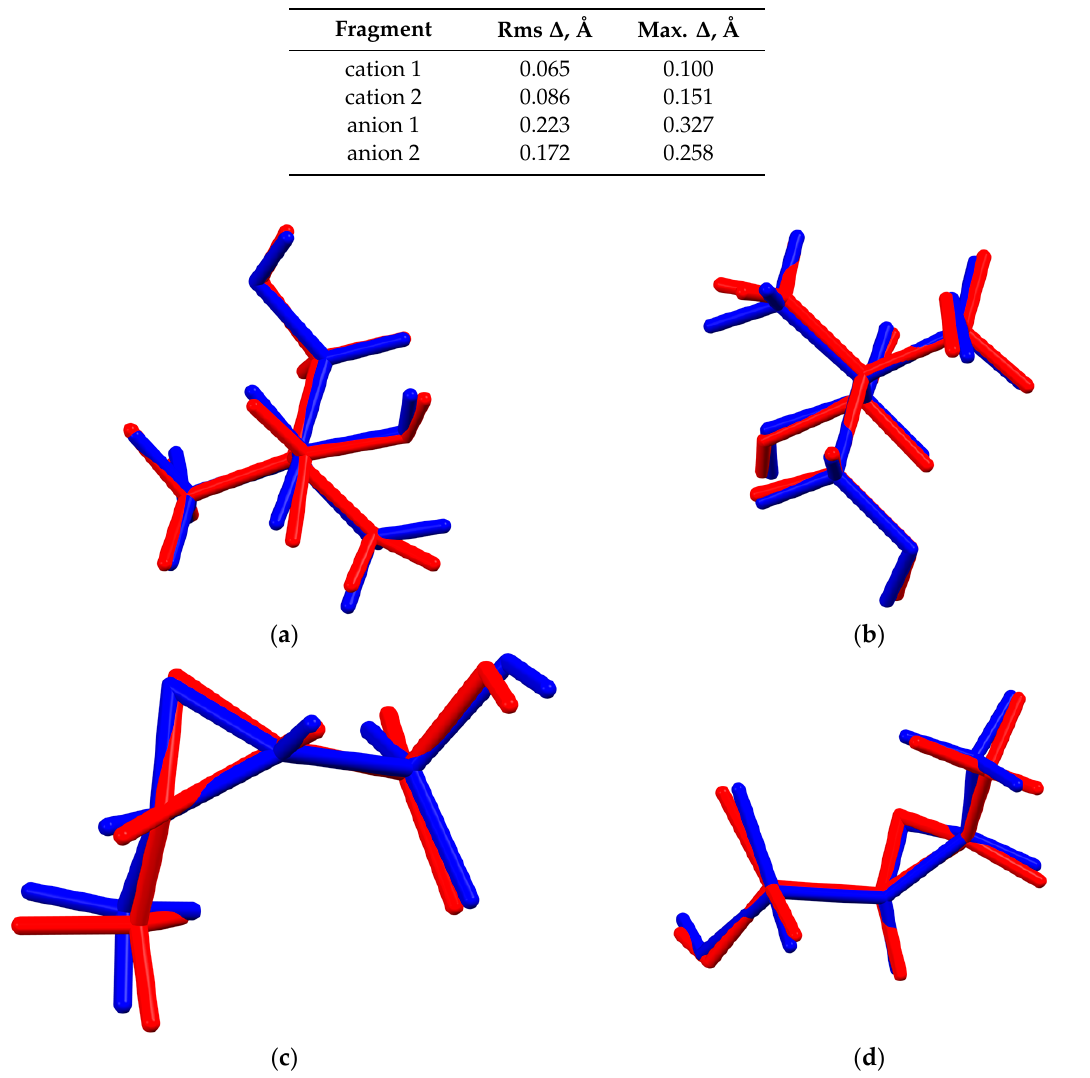
Figure 3. ( a ) Comparison of the Rietveld-refined (red) and CRYSTAL14-optimized (blue) structures of cation 1 of fosfomycin tromethamine. ( b ) Comparison of the Rietveld-refined (red) and CRYSTAL14-optimized (blue) structures of cation 2 of fosfomycin tromethamine. ( c ) Comparison of the Rietveld-refined (red) and CRYSTAL14-optimized (blue) structures of anion 1 of fosfomycin tromethamine. ( d ) Comparison of the Rietveld-refined (red) and CRYSTAL14-optimized (blue) structures of anion 2 of fosfomycin tromethamine.